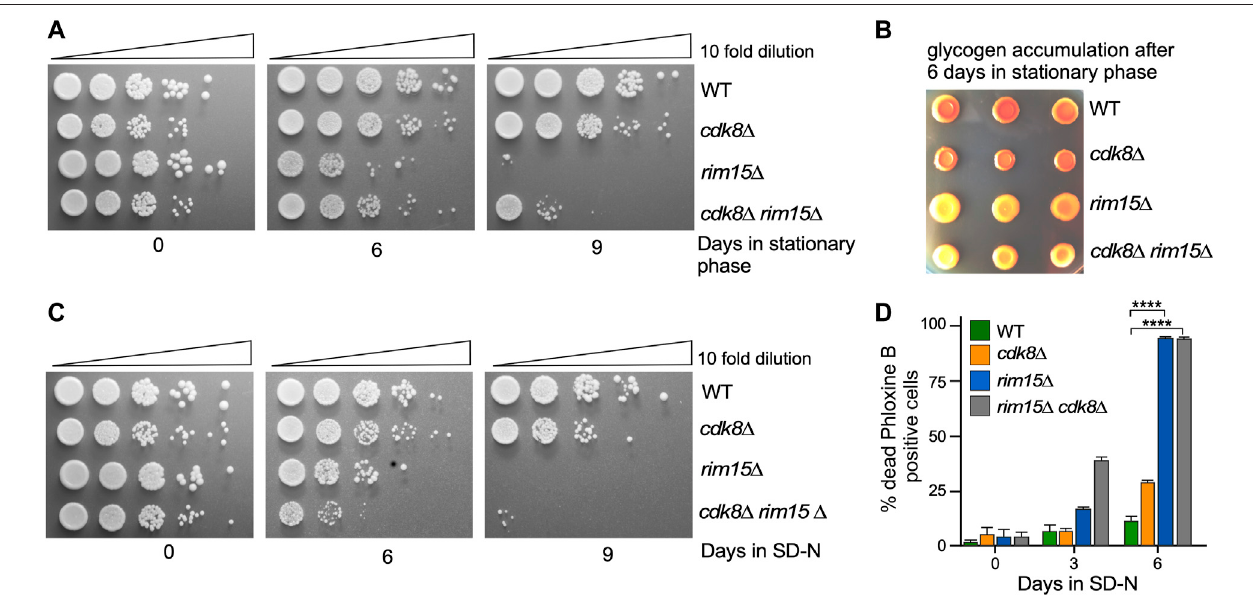
FIGURE 2 | rim15 Δ is epistatic to cdk8 Δ . (A) Quiescent survival assays of the strains shown after induction of stationary phase. Mid-log liquid YPD cultures were kept in stationary phase for the number of days shown. Ten-fold serial dilutions of the cells were then plated onto fresh YPD plates and growth recorded after 48 h at 30 ° C. (B) AsinAexceptthatthecellswerescoredforglycogenaccumulation. (C) AsinAexceptthatthecellsweredepletedofnitrogenforthedaysindicate. (D) Mid-log cells with the genotypes shown were washed then switched to SD-N medium. The percent of inviable cells within the population was determined using phloxine B staining and FACs analysis after 3 days. N = 3. NS p ≥ 0.05; * p ≤ 0.05; ** p ≤ 0.01; *** p ≤ 0.005; **** p ≤